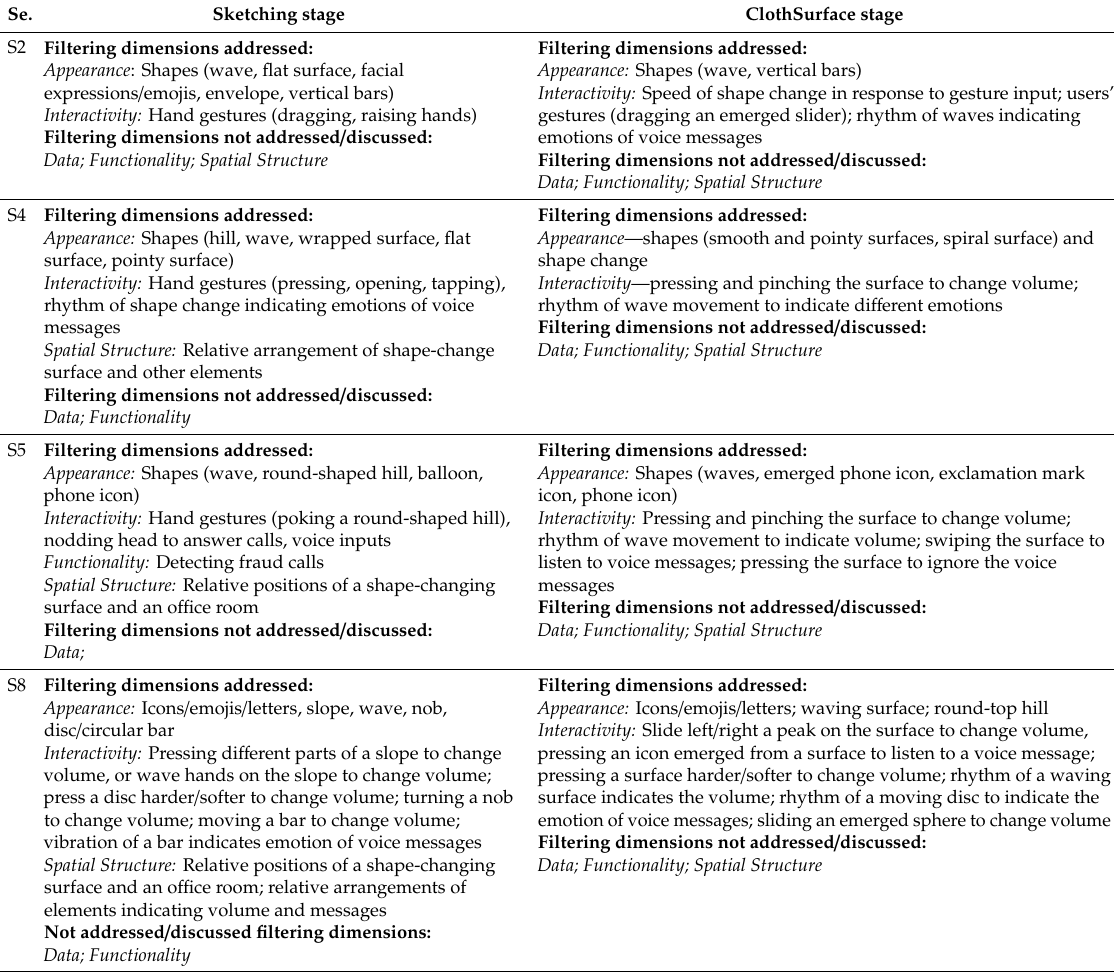
Table A3. Filtering Dimensions in the Sessions Assigned to the O ffi ce Phone Design Tasks (2A & 2B). Se. Sketching stage ClothSurface